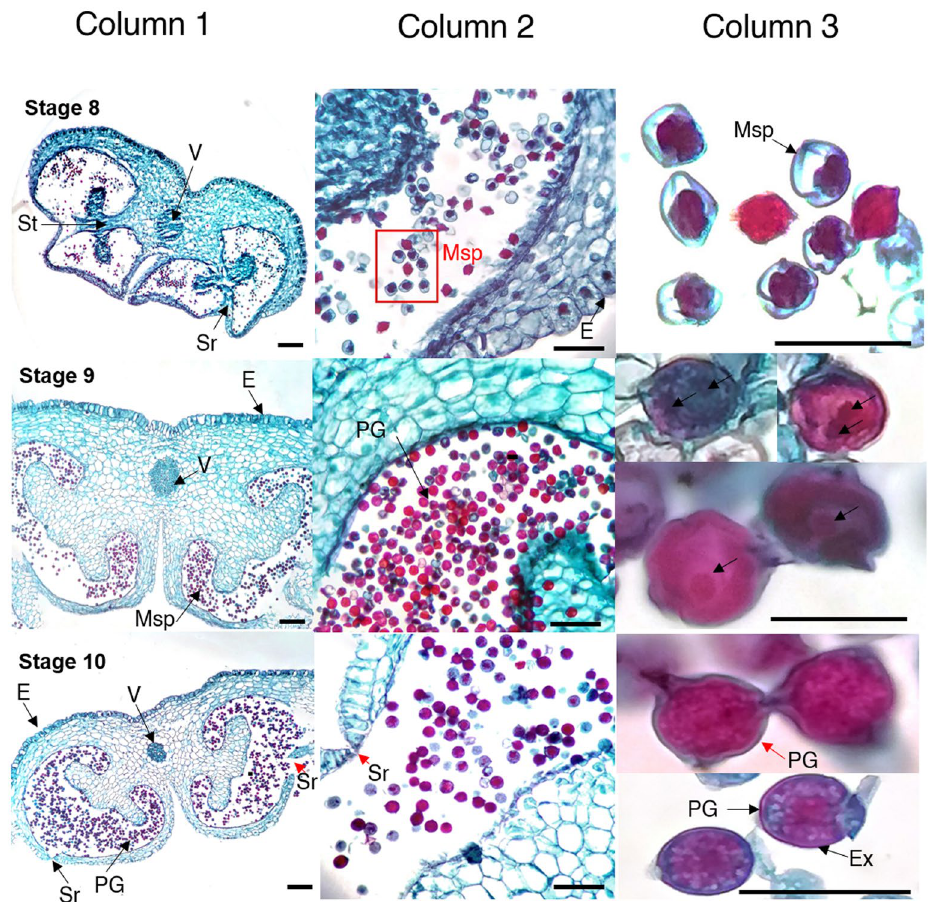
Figure 4. Anther development and pollen formation in diploid yellow potato ( Solanum tuberosum Phureja Group) Criolla Colombia cultivar. States of development: 8–10. E epidermis, Ex exine, Msp microspore, PG